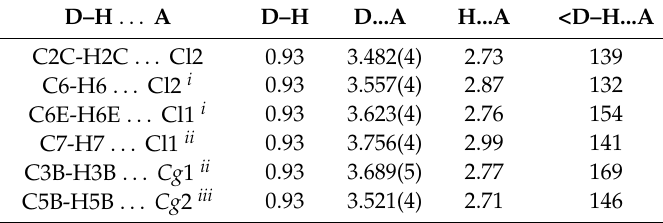
Table 4. The geometry of intermolecular interactions in the [Pd( 6q )Cl 2 ] (Å, ◦ )